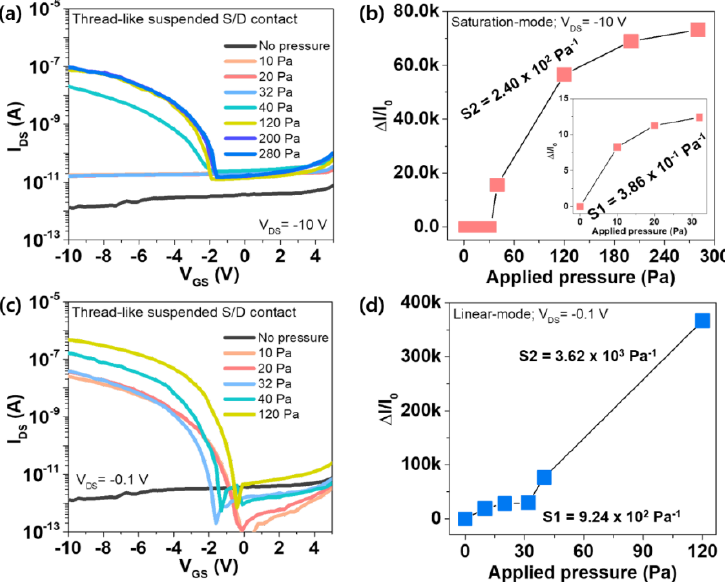
Figure 3. ( a ) The transfer curve of the FTPS device under di ff erent applied pressures at V DS = − 10 V (saturation-mode). ( b ) The relative change in the drain-source current ( I DS ) of the FTPS as a function of the applied pressure from 0 to 280 Pa in the saturation-mode. ( c ) The transfer curve of the FTPS device under di ff erent applied pressures at V DS = − 0.1 V (linear-mode). ( d ) The relative change in the drain-source current ( I DS ) of the FTPS as a function of the applied pressure from 0 to 120 Pa in the linear-mode.